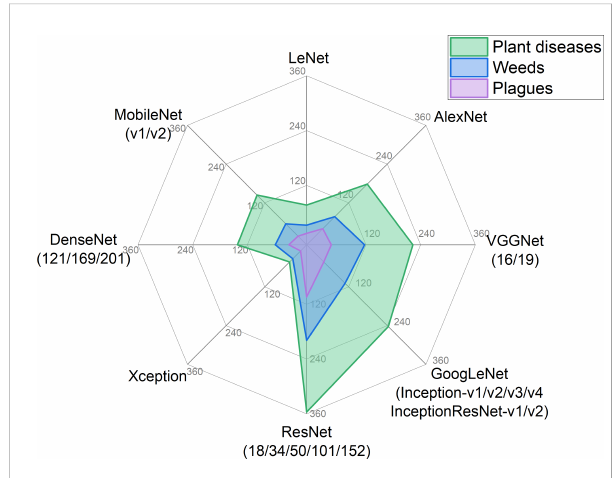
FIGURE 3 Number of publications of CNN architectures commonly used in the three domains of precision crop protection (crop diseases, weeds and crop plagues) from 2010 to 2022 (source: Scopus). Figure compiled with the conjunction of “ CNN architecture ” and each of the three crop protection domains (crop diseases, weeds and crop plagues) as search criteria within the article title, abstract and